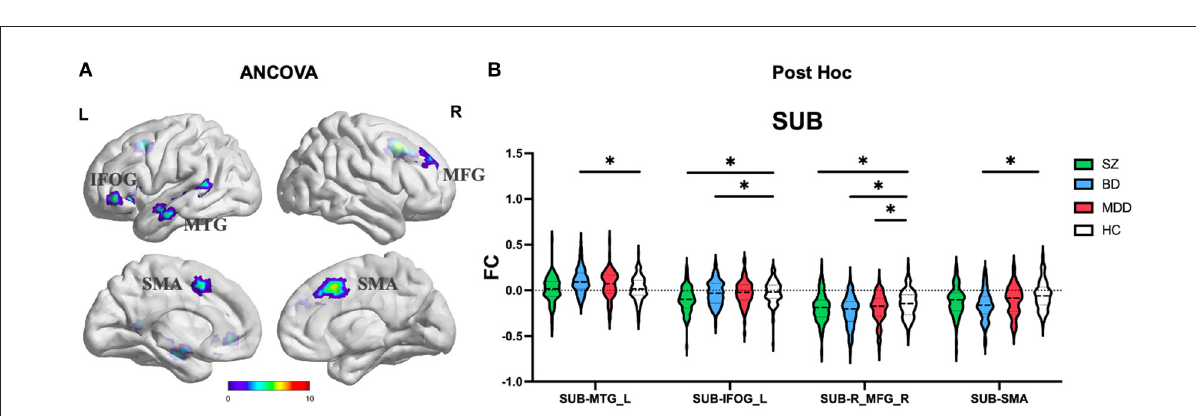
FIGURE4 The FC alterations of SUB subregion analyzed by (A) ANCOVA analyzed. (B) The post hoc pair-wise t test. FC, Functional Connectivity; SUB, Subiculum; ANCOVA, Analysis of Covariance; SZ, Schizophrenia; BD, Bipolar Disorder; MDD, Major Depressive Disorder; GRF, Gaussian Random Field. ANCOVA: Significance was set at cluster p < 0.05 corrected using GRF with voxel p < 0.005. Post-hoc : *Significance was set at cluster p < 0.05 corrected using GRF with voxel p <